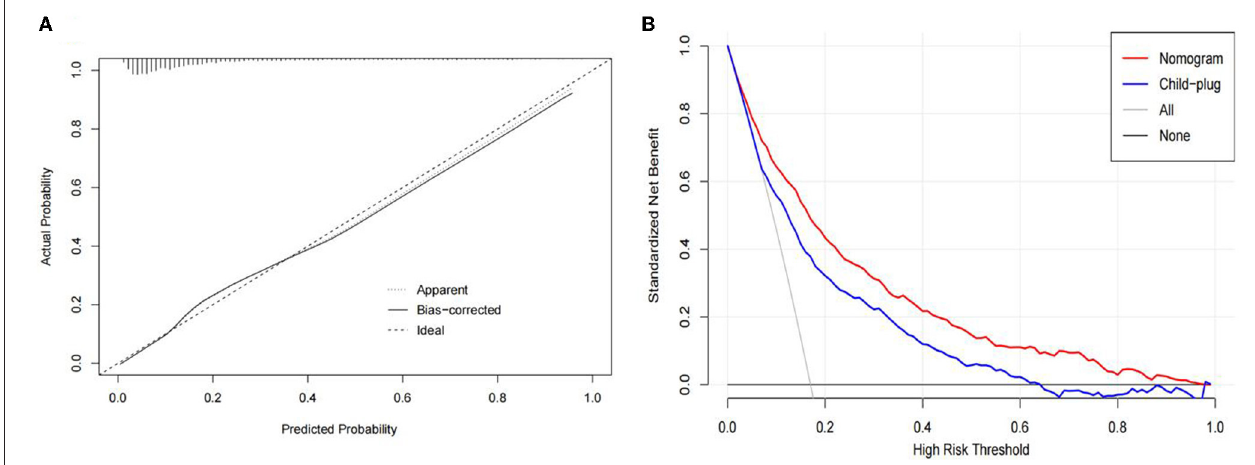
FIGURE 4 | (A) Calibration curves of the spontaneous bacterial peritonitis incidence risk nomogram prediction in the traindata. The diagonal line represents the reference line of complete coincidence between the predicted value and the actual value, The apparent dotted line represents the actual situation of the prediction model, and the bias-corrected solid line represents the actual situation of the prediction model after correction. (B) Decision curve analysis of the nomogram and child-plug. The y-axis represents standardized net